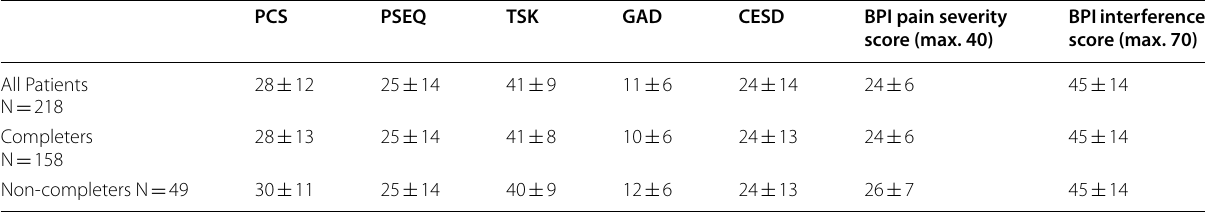
Table 2 Mean ( SD) scores for all patients, completers and non-completers on outcome measures at ENTRY ± PCS PSEQ TSK GAD CESD BPI pain severity